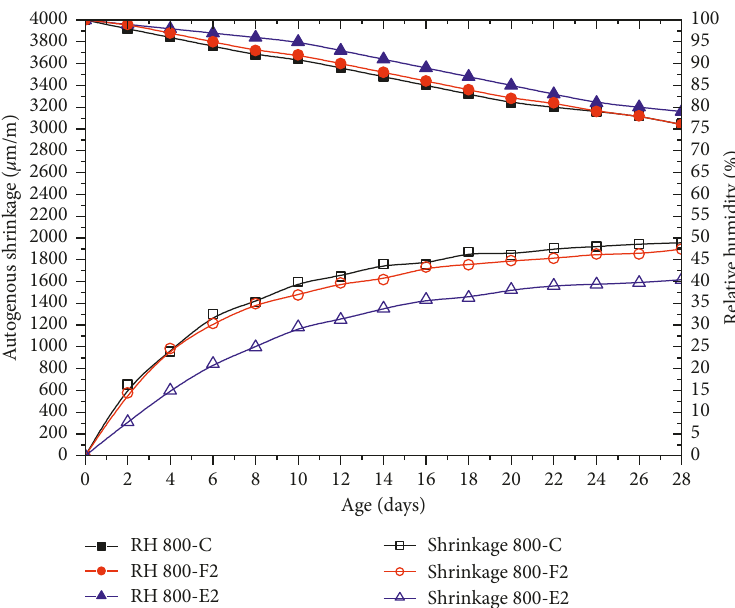
Figure 6: Interior humidity and autogenous shrinkage versus time diagrams of the foam